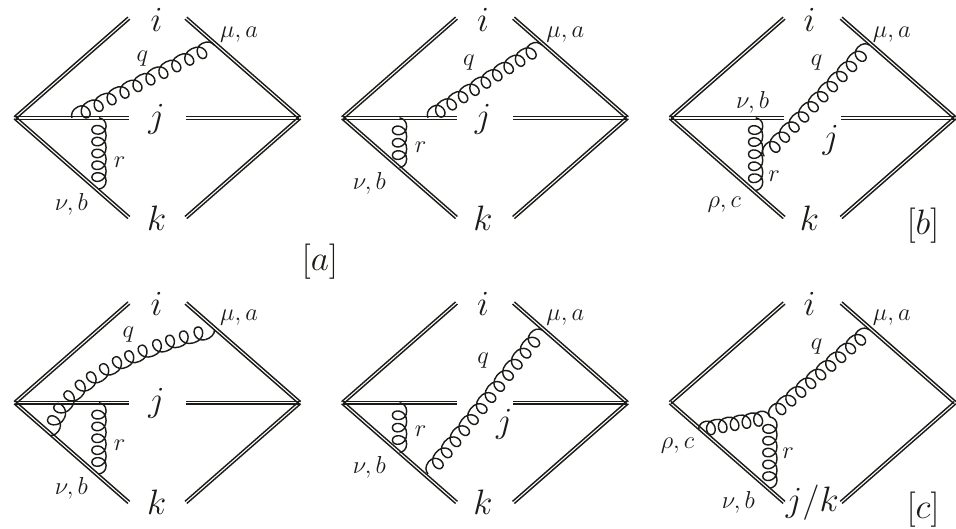
Figure 1 . Real-virtual diagrams. We denote the contribution from the left four diagrams as part [ a ]) while the upper and lower diagram on the right are parts [ b ] and [ c ] , respectively. The symmetry of part [ a ] under exchange of j and k is broken when these lines have opposite directionalities as considered here. In this case there is a second diagram in category [ c ] , where we attach to k instead of j